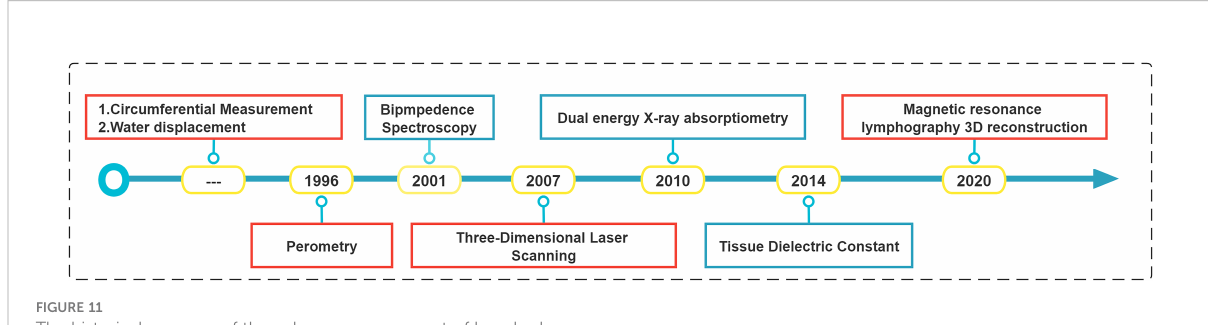
FIGURE 11 The historical progress of the volume measurement of